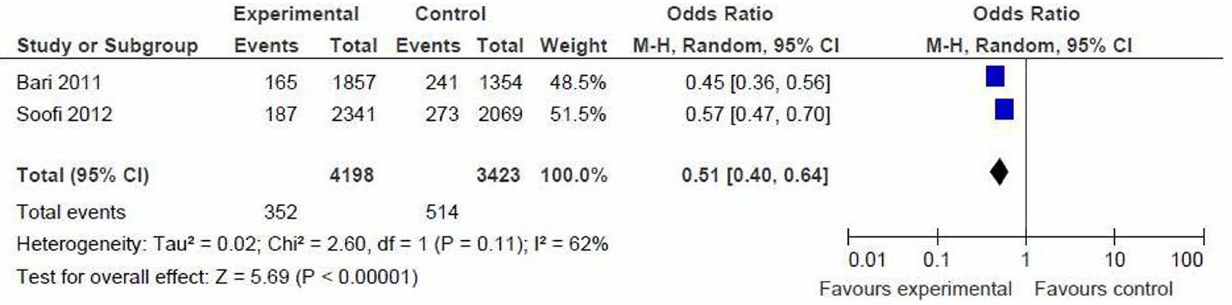
Figure 3. Primary outcome measures [oral amoxicillin versus oral cotrimoxazole and referral]. Proportion of children developing treatment failure at day 6.